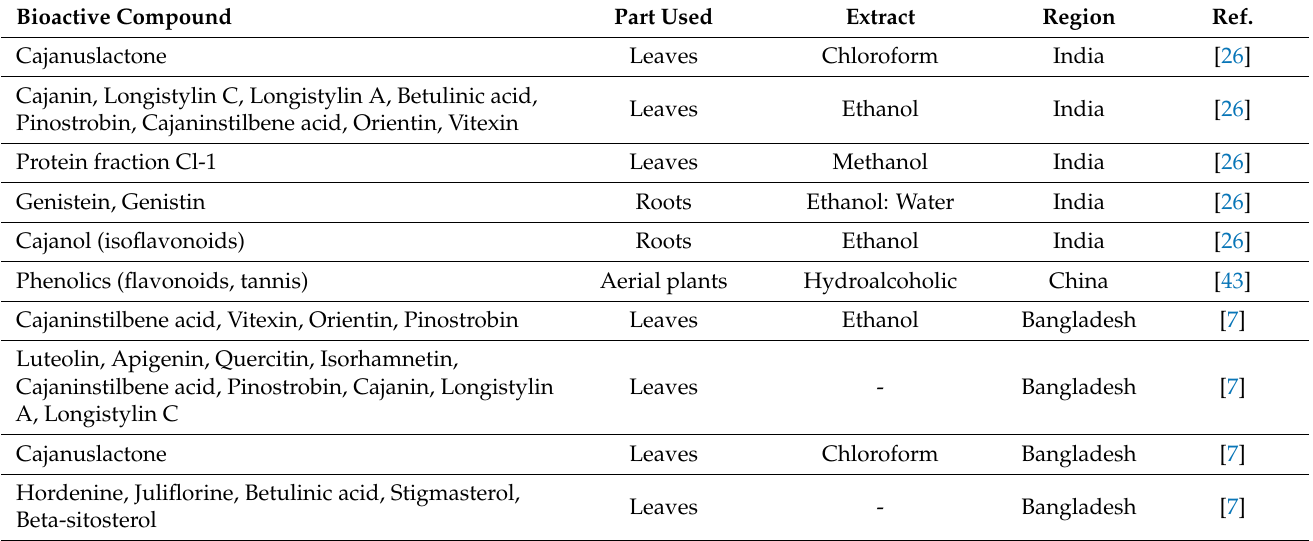
Table 6. Bioactive components present in Cajanus cajan from different regions.